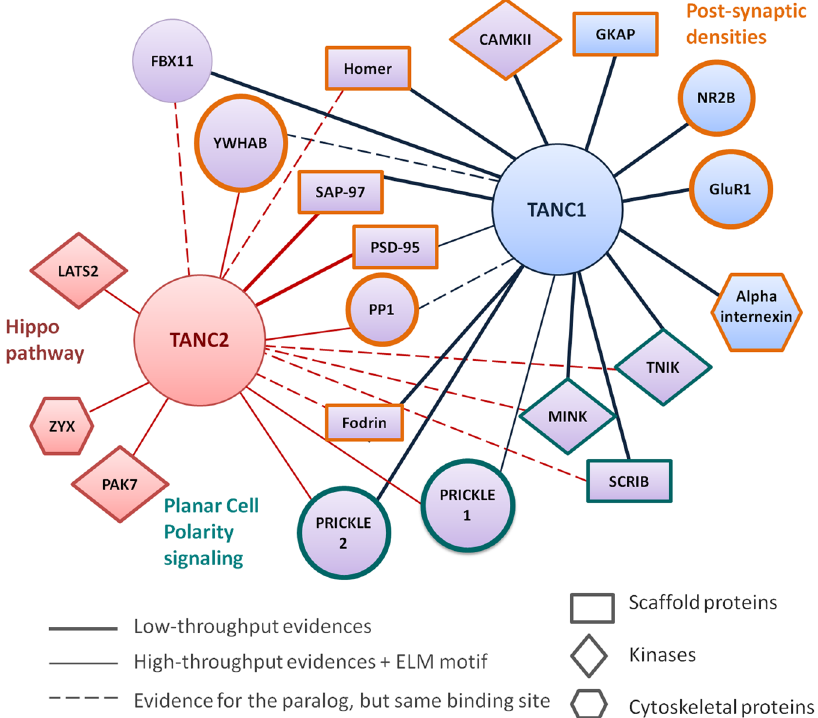
Figure 6. TANC protein interaction network. TANC interaction partners identified by low throughput data (solid lines), PPI database evidence (thinner lines) or linear motifs prediction. Interactions that are proved only in one paralog, but mediated by binding sites (linear motif or structural domain) that are identical in both proteins, are reported as dotted edges. TANC1 interactors only are colored in light blue; TANC2 interactors only in red: while TANC interactors both are in violet. Interactors are represented with different shapes based on specific molecular function: scaffold proteins (rectangles), protein kinases (rhombus); cytoskeleton proteins (hexagons). TANC proteins are connected with different neuronal regulative proteins, belonging to Planar Cell Polarity signalling (teal outline), Hippo pathway (dark red outline) and glutamate signalling (orange